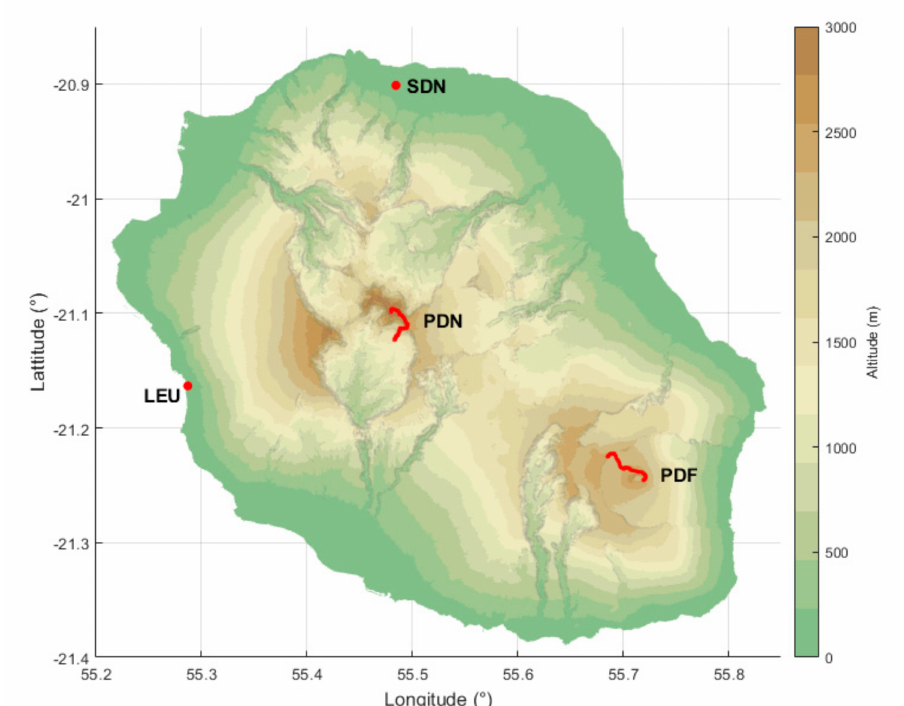
Figure 2. Measurement campaign locations at Reunion Island. The red dots show St-Leu Beach (LEU) and OPAR UV station at Saint-Denis (SDN). The red lines show the hike paths during the Piton de la Fournaise (PDF) and Piton des Neiges (PDN) hikes. The color bar on the right side displays the altitude in